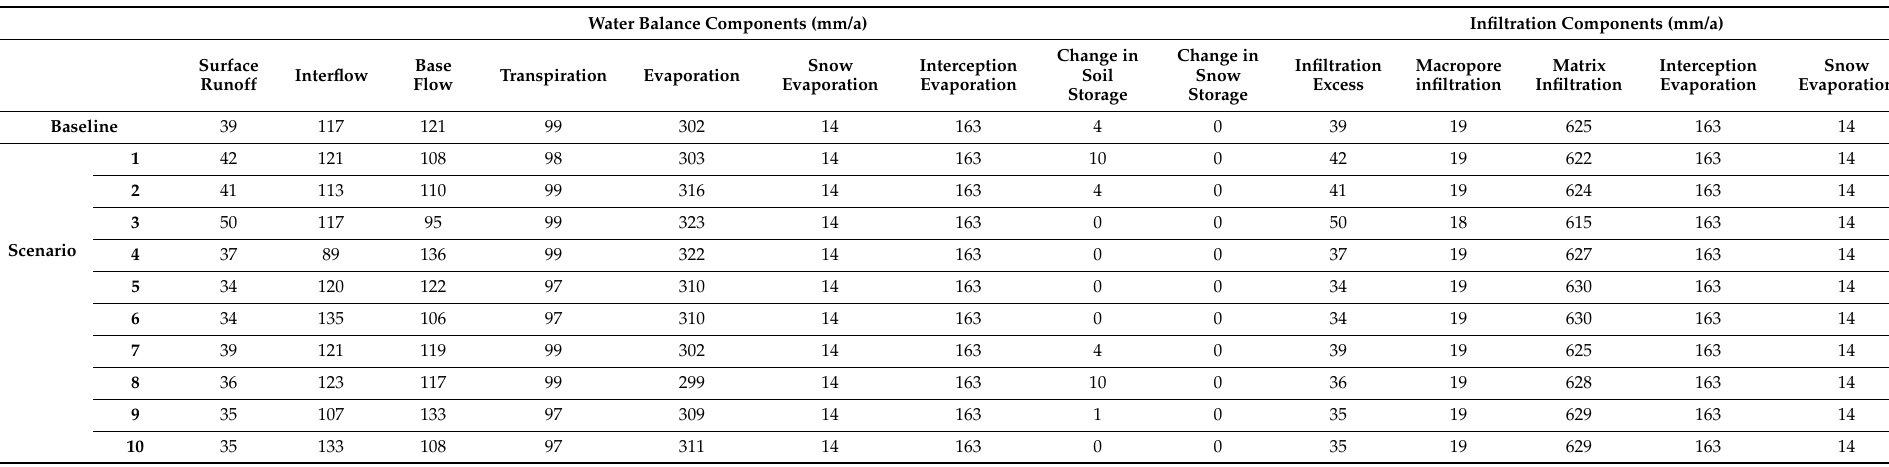
Table 7. Mean annual amount of the water balance and infiltration components for the baseline scenario and the 10 scenarios. Water Balance Components